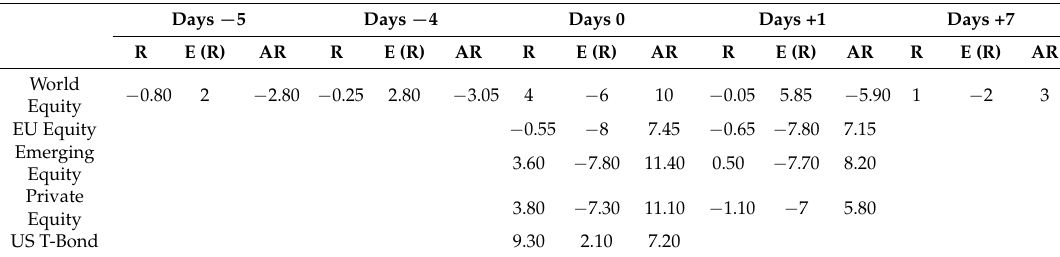
Table 6. Significant Abnormal